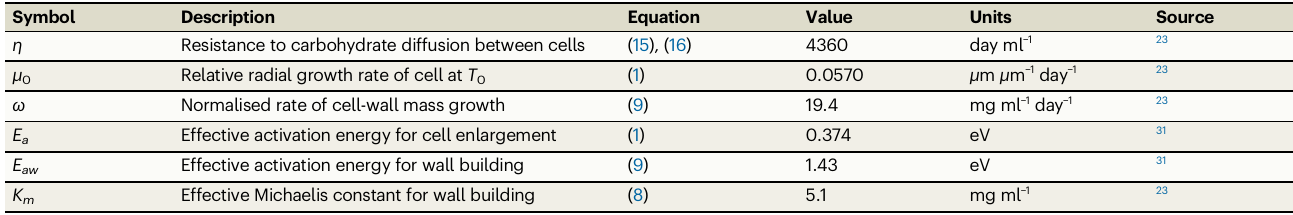
Table 1 | Model parameters calibrated to observations Symbol Description